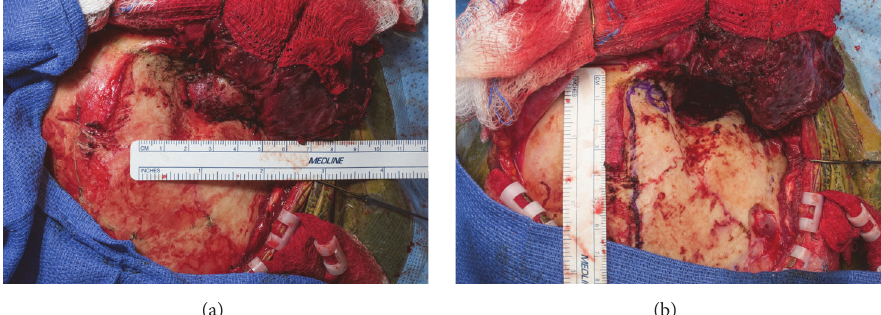
Figure 2: Intraoperative photos of the firm, encapsulated tumor penetrating through the temporal bone and involving the temporalis muscle, (a) before and (b) after debulking the tumor extracranially.